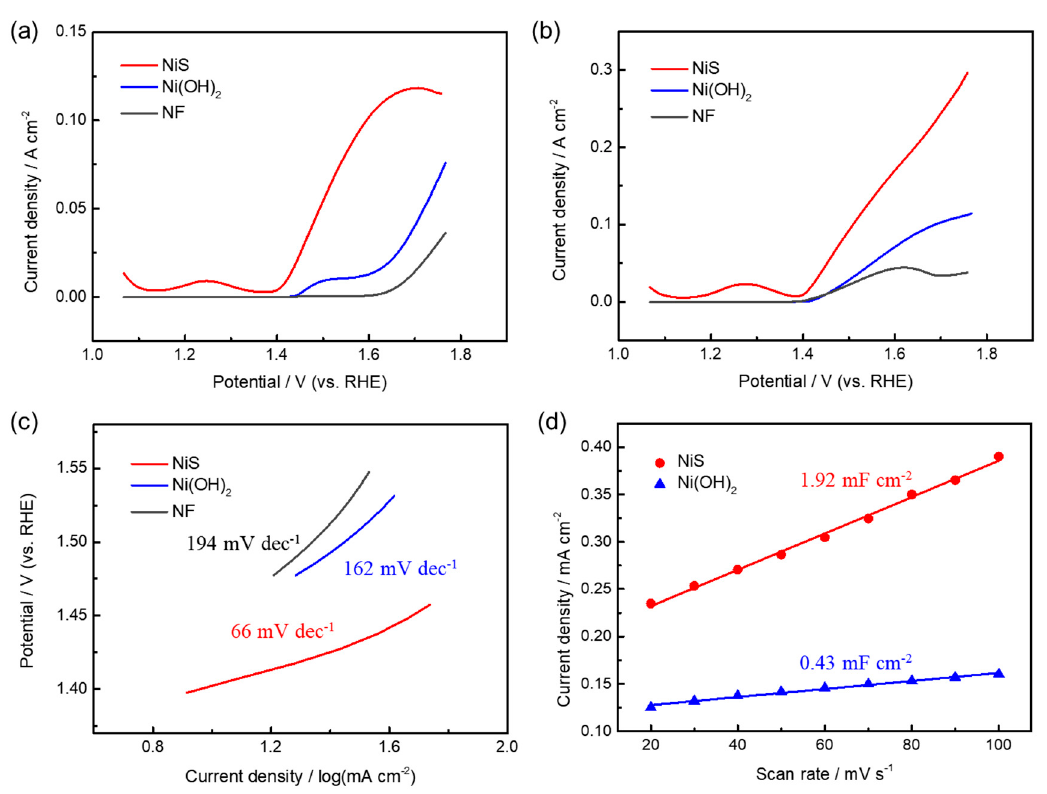
Figure 4. LSV curves of NiS, Ni(OH) 2 , and Ni foam (NF) in ( a ) 1 M KOH and ( b ) 1 M KOH with 0.33 M urea at the scan rate of 5 mV s − 1 ; ( c ) Tafel plot and ( d ) double − layer capacitance of NiS and Ni(OH) 2 in 1 M KOH with 0.33 M urea.